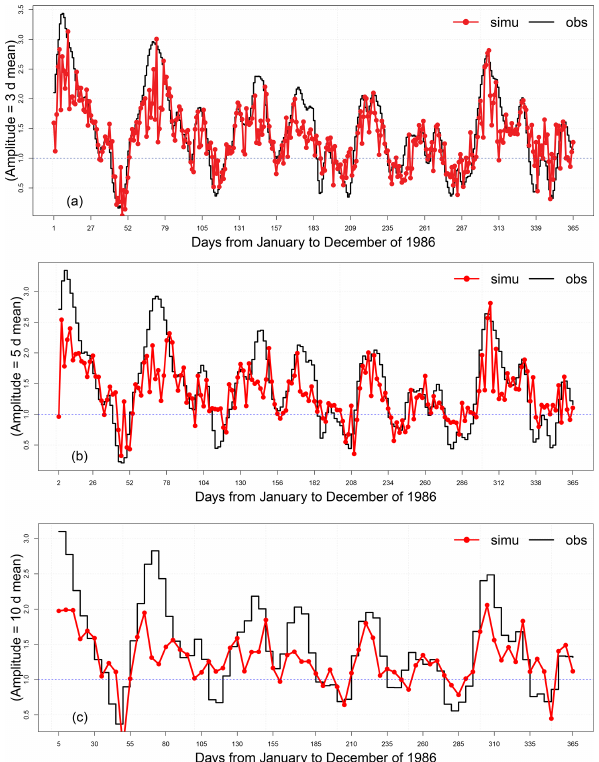
Figure A4. Time series of observations and simulations of the MJO amplitude computed from analogs of Z300 for lead times of 3 (a) , 5 (b) , and 10d (c) for the year 1986. The red line represents the mean of the 100 simulations, the black line represents the observa- tions, and the blue line indicates the threshold of the MJO activity A ( t ) >